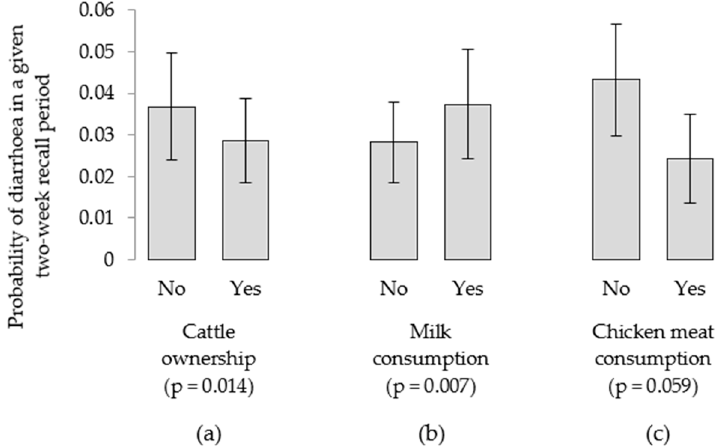
Figure 7. Probability of child diarrhea being reported in a given two-week period, according to ( a ) household cattle ownership, and ( b ) children’s consumption of milk or ( c ) chicken meat the previous day.